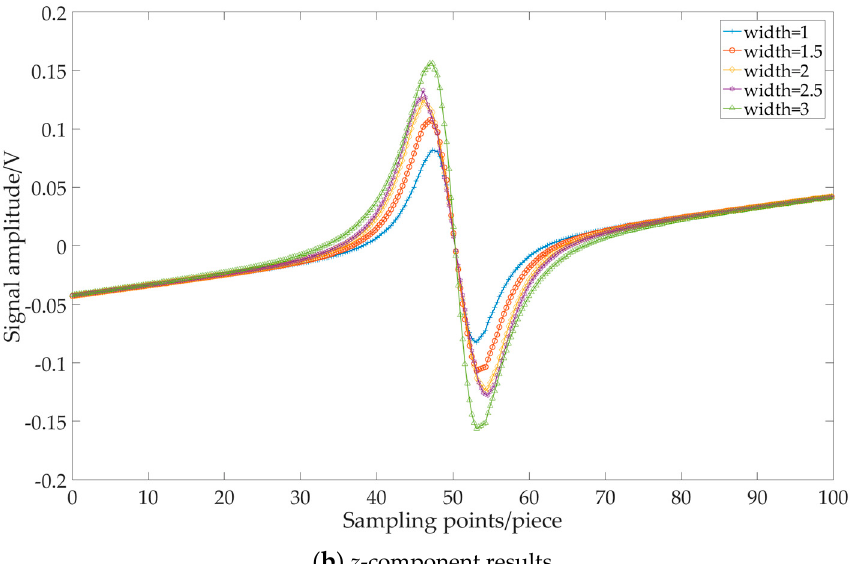
Figure 6. Results with different width.